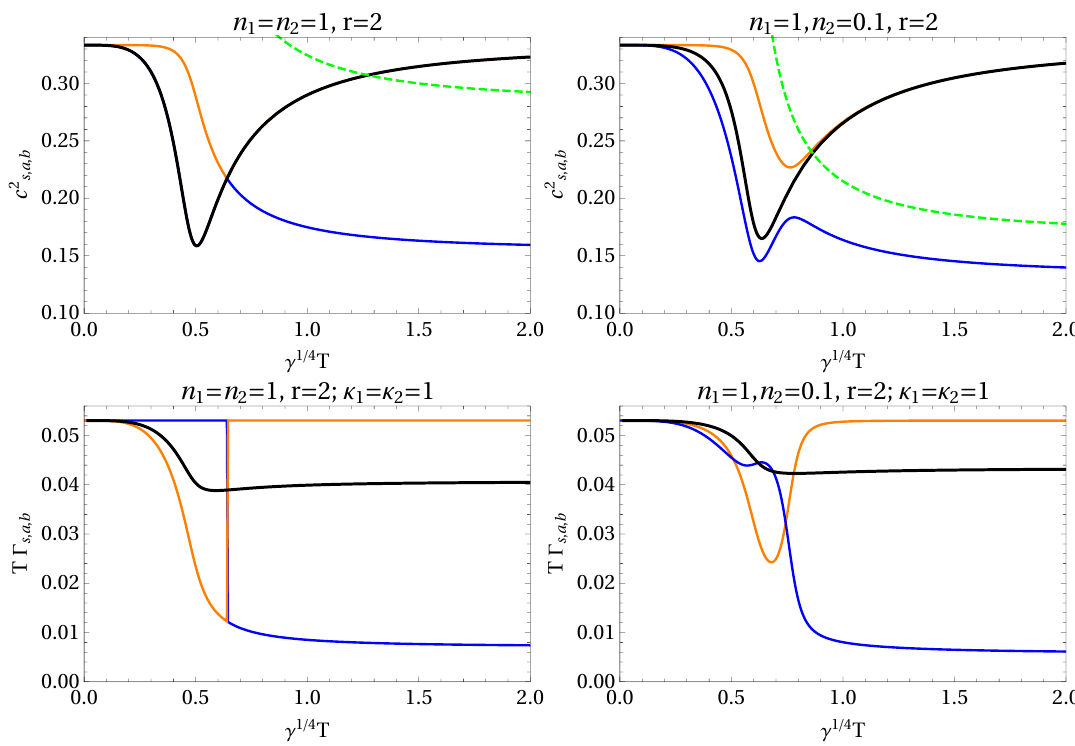
Figure 10 . Sound modes and their attenuation coe(cid:14)cients for equal and unequal conformal sys- tems, same (cid:20) = 1 (corresponding to (cid:17) i =s i = 1 = 4 (cid:25) ), with the slower mode a plotted in blue, and the faster mode b plotted in orange. The black line represents the thermodynamic speed of sound and associated attenuation coe(cid:14)cient from the Kubo formula. The green dashed line shows the light-cone velocities squared of the two subsystems (in the case of n 2 = 1 = 10 only ~ v 2 is in plot region). In the case n 1 = n 2 the lines for c 2 meet and could be continued smoothly by switching a;b the designation; however for any n 1 6 = n 2 we have c b > c a at nonzero (cid:13) 1 = 4 T . The discontinuous behavior of the damping rates (cid:0) a;b for n 1 = n 2 is in fact the limit of smooth curves as n 1 ! n 2 from di(cid:11)erent starting values.